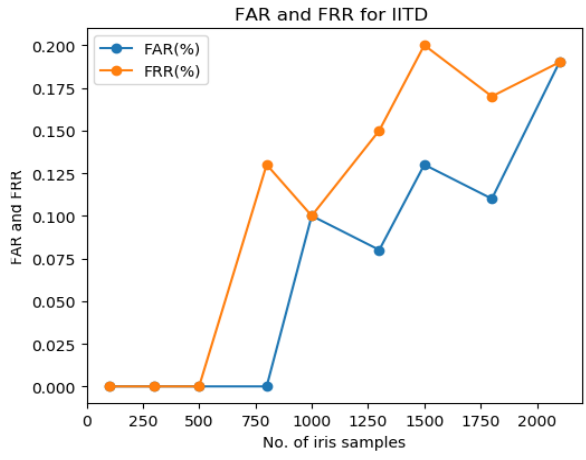
Figure 5. Plot of FAR and FRR in the IITD iris dataset.